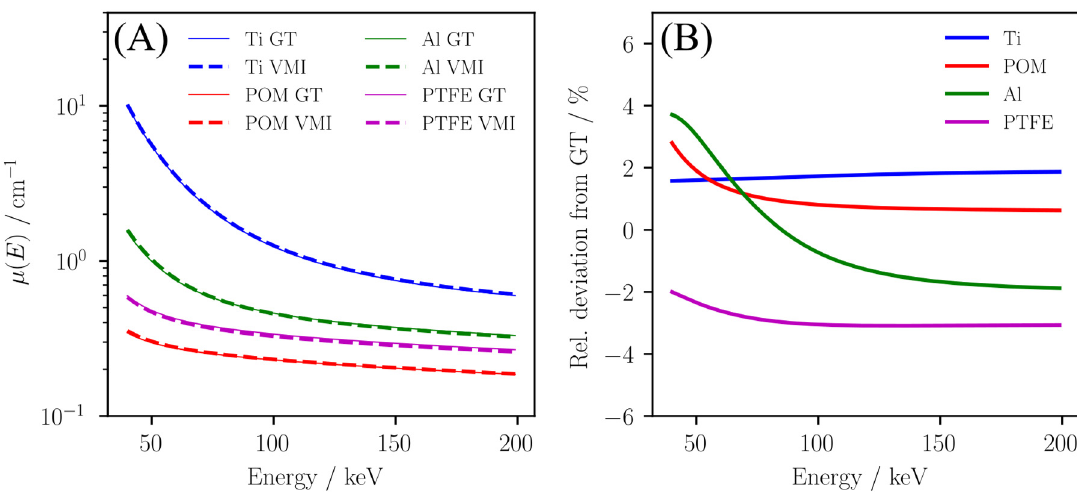
Fig 4. Quantitative accuray of virtual monoenergetic images. The VMIs calculated from the obtained basis material images (c. f. Fig 3B and 3C)) are compared to the theoretical attenuation values (label GT) of the studied materials (A) in the energy range from 40 to 200 keV. (B) shows the relative deviation between the values extracted from the measurement and the corresponding ground truth values. The theory values were taken from the XCOM database [31].